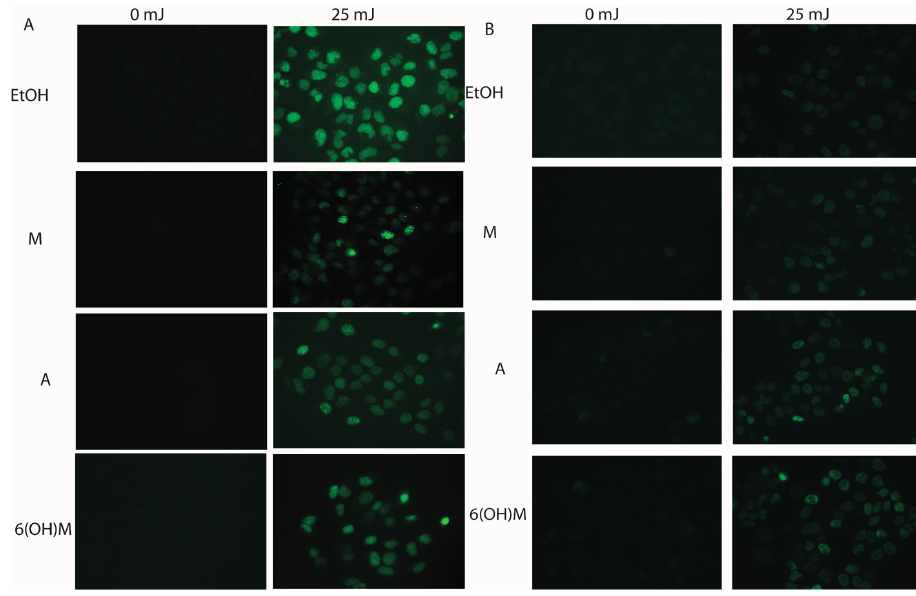
Figure 7. Melatonin (M), 6-hydroxymelatonin (6(OH)M) and AFMK (A) treated keratinocytes decrease CPD formation ( A ) or increase of p53 phosphorylated at Serine 15 ( B ) after UVB exposure. HEKn keratinocytes were treated with melatonin or its derivatives for 24 h before UVB exposure. Cells were exposed to UVB intensities of 25 mJ/cm 2 and immediately treated again with melatonin or its derivatives for 3 h ( A ) or 12 h ( B ). Cells were fixed and stained with anti-CPD ( A ) or anti-phosphorylated p53S15 ( B ) antibodies (green) as described in